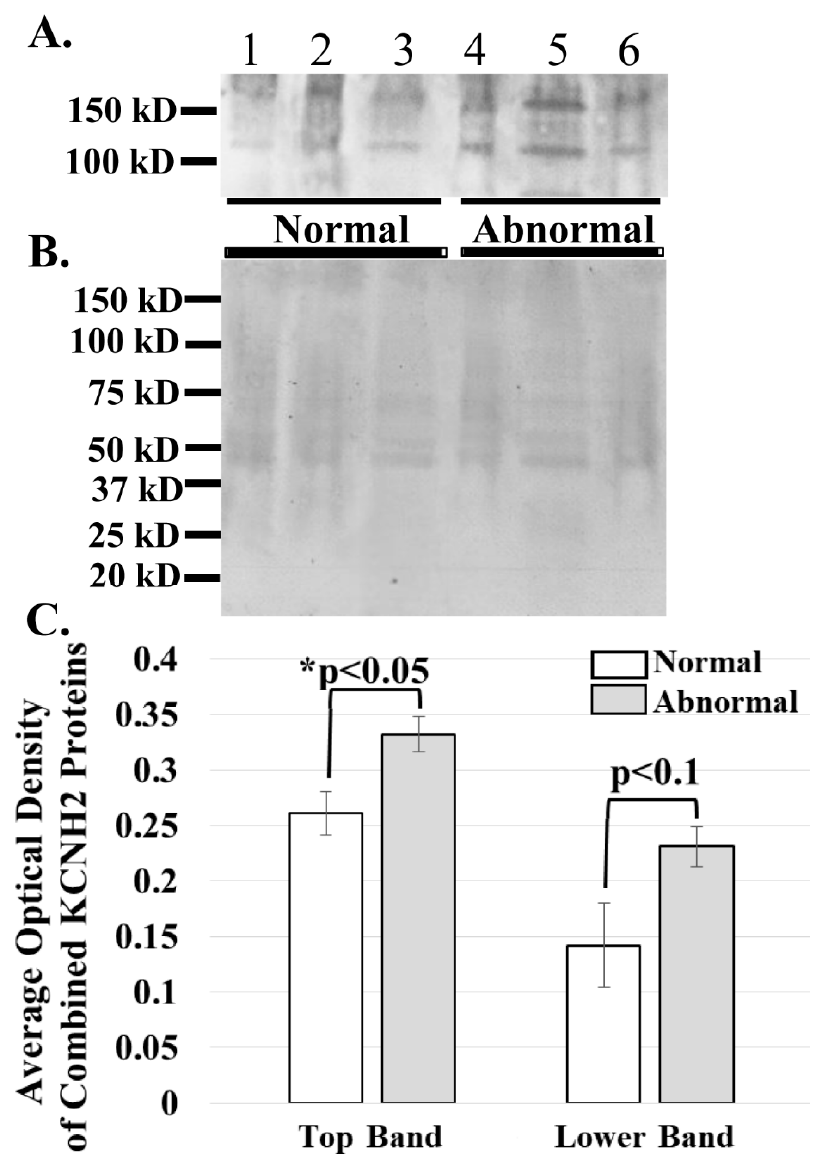
Figure 4. ERG1A protein variants are more abundant in the skeletal muscle of cancer patients than in that of healthy humans. ( A ) Human limb skeletal muscle membrane homogenates were prepared from both cancer patients (Abnormal) and healthy (Normal) humans and immunoblotted (50 μ g) to show that the ERG1A protein is more abundant in the muscle from cancer patients than in healthy individuals; ( B ) Coomassie stain of the immunoblotted membrane reveals that equal amounts of membrane homogenate protein were loaded into the wells for SDS-PAGE; ( C ) The graph demonstrates the difference in mean optical densities (OD) of the ERG1A proteins. The bars represent the average OD ± the standard error of the mean of either the top or lower (as indicated) ERG1 protein bands in Panel A. The “*” represents a statistical difference ( p < 0.05).